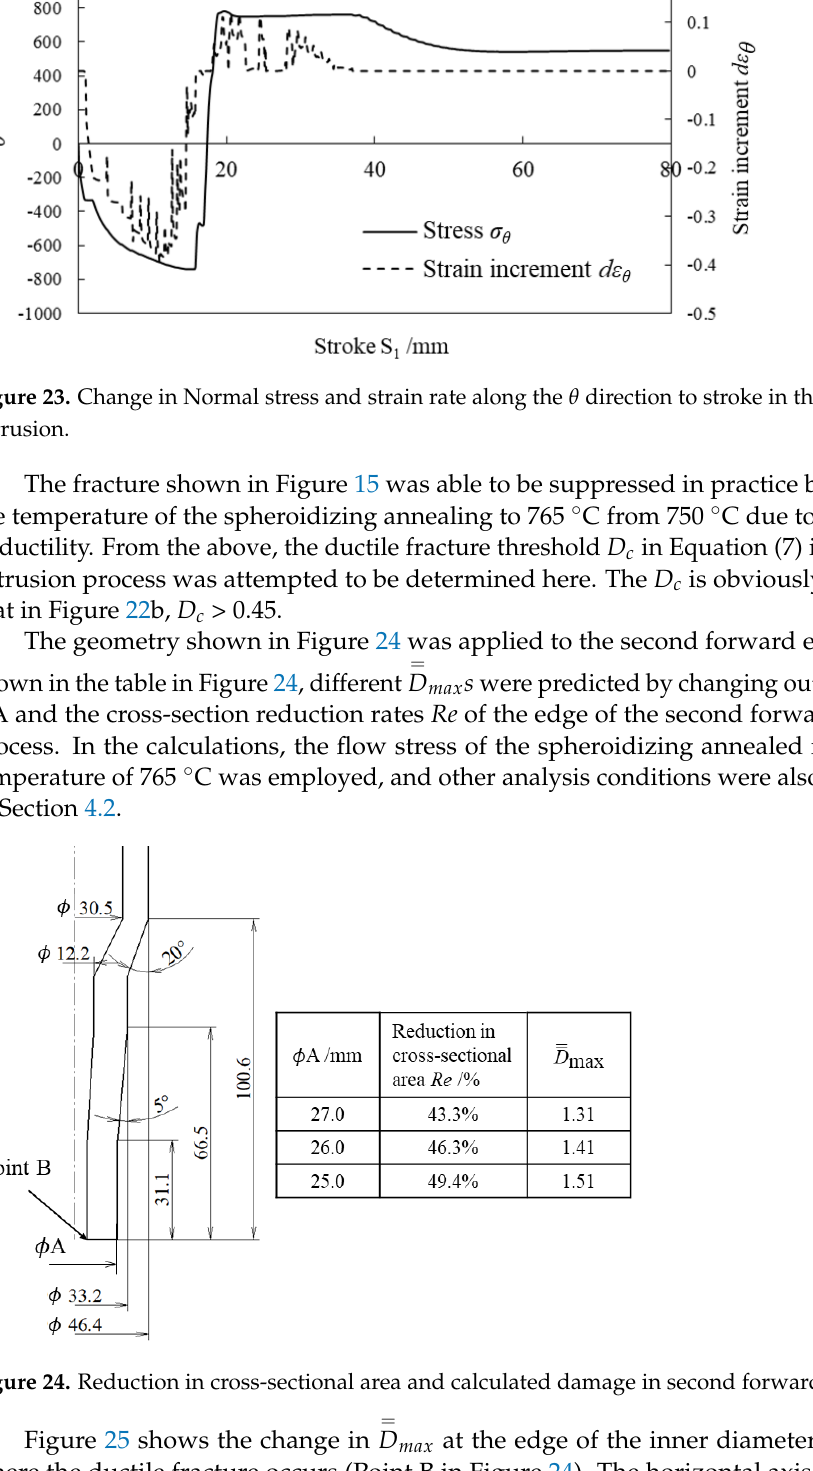
Figure 22. Distribution of ductile damage in first forward extrusion.